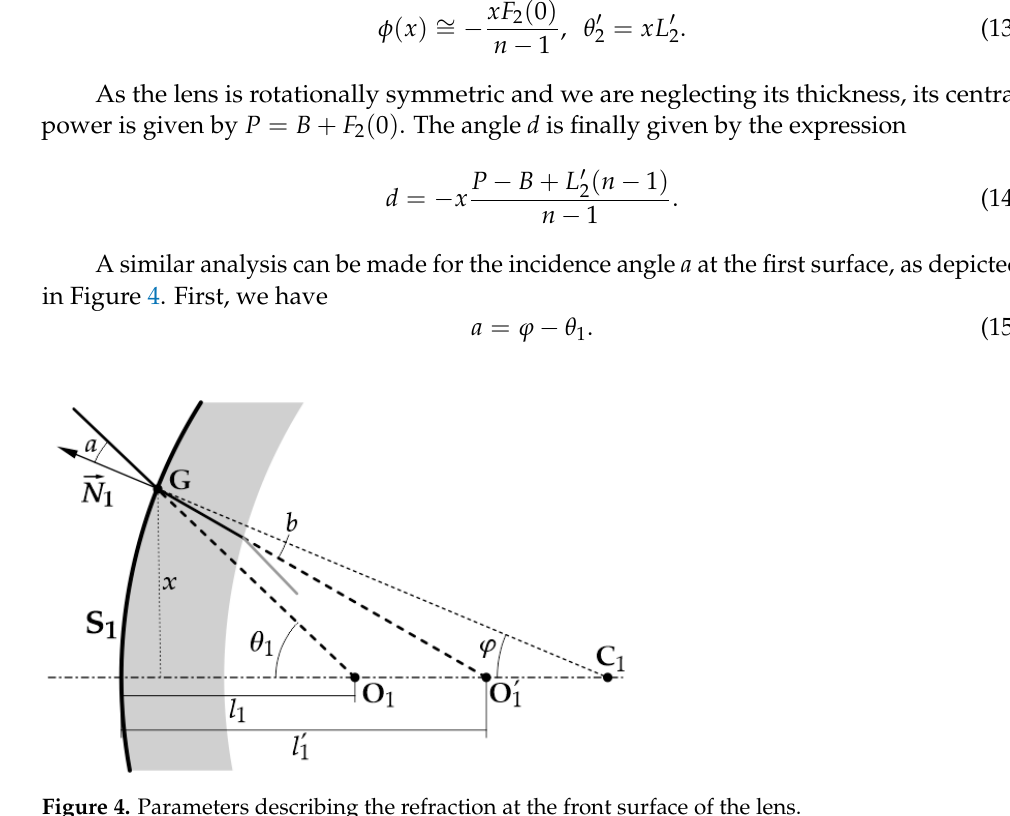
Figure 3. Parameters describing the refraction at the back surface of the lens. The angle d is given by